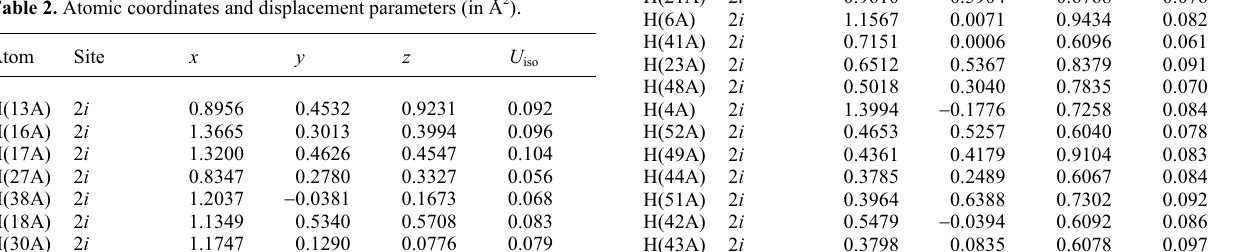
Table 2. Atomic coordinates and displacement parameters (in Å 2 ) .